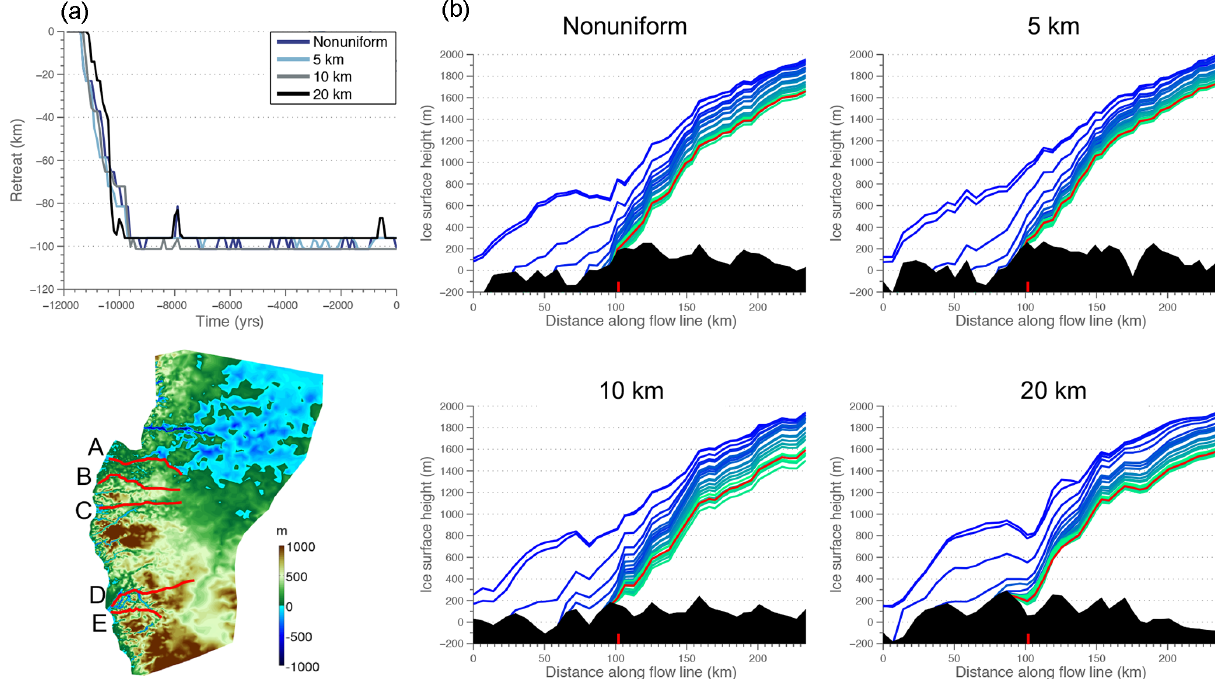
Figure 7. (a) Simulated retreat along flow line A for each model. (b) Ice surface profiles shown at 500-year intervals (blue: older; green: younger; the red line indicates the simulated present-day ice surface profile), with the underlying bed topography (filled black area). The red tick mark on the x axis denotes the present-day ice margin (Howat et al., 2014). Readers should refer to this figure for locations of flow lines used in this